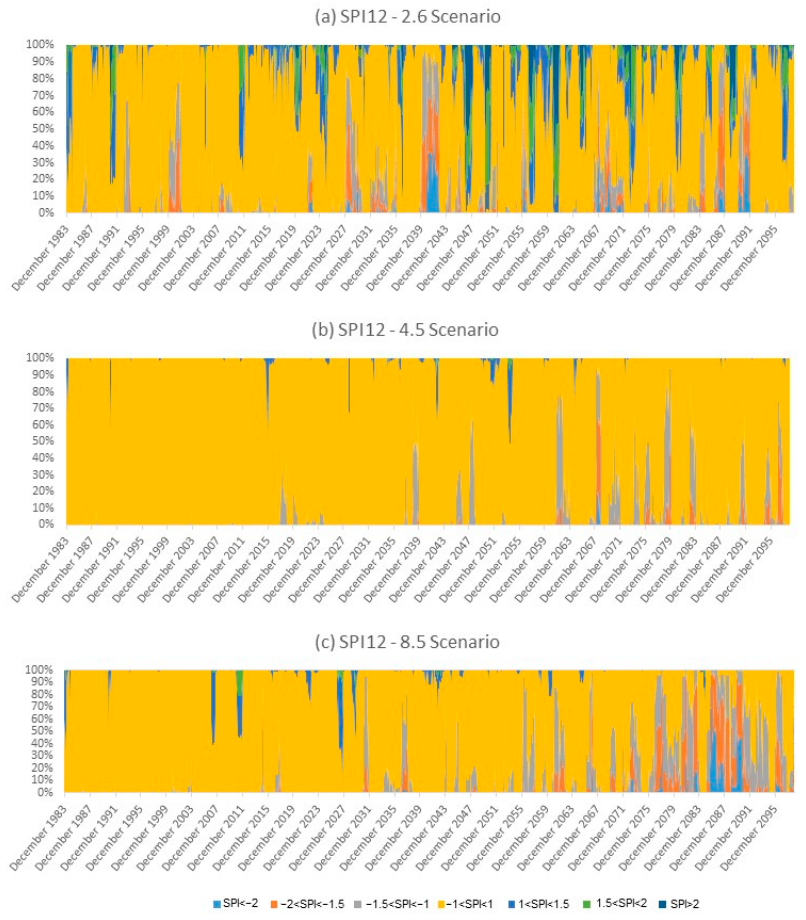
Figure 2. Temporal distribution of SPI12 index as a percentage of Crete under each RCP2.6 ( a ), RCP4.5 ( b ) and RCP8.5 ( c ) categories.